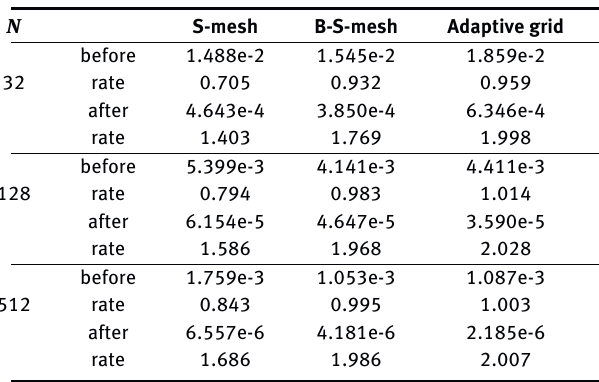
Table 2: E N ε , u and the corresponding r N ε , u for Example 6.2. N